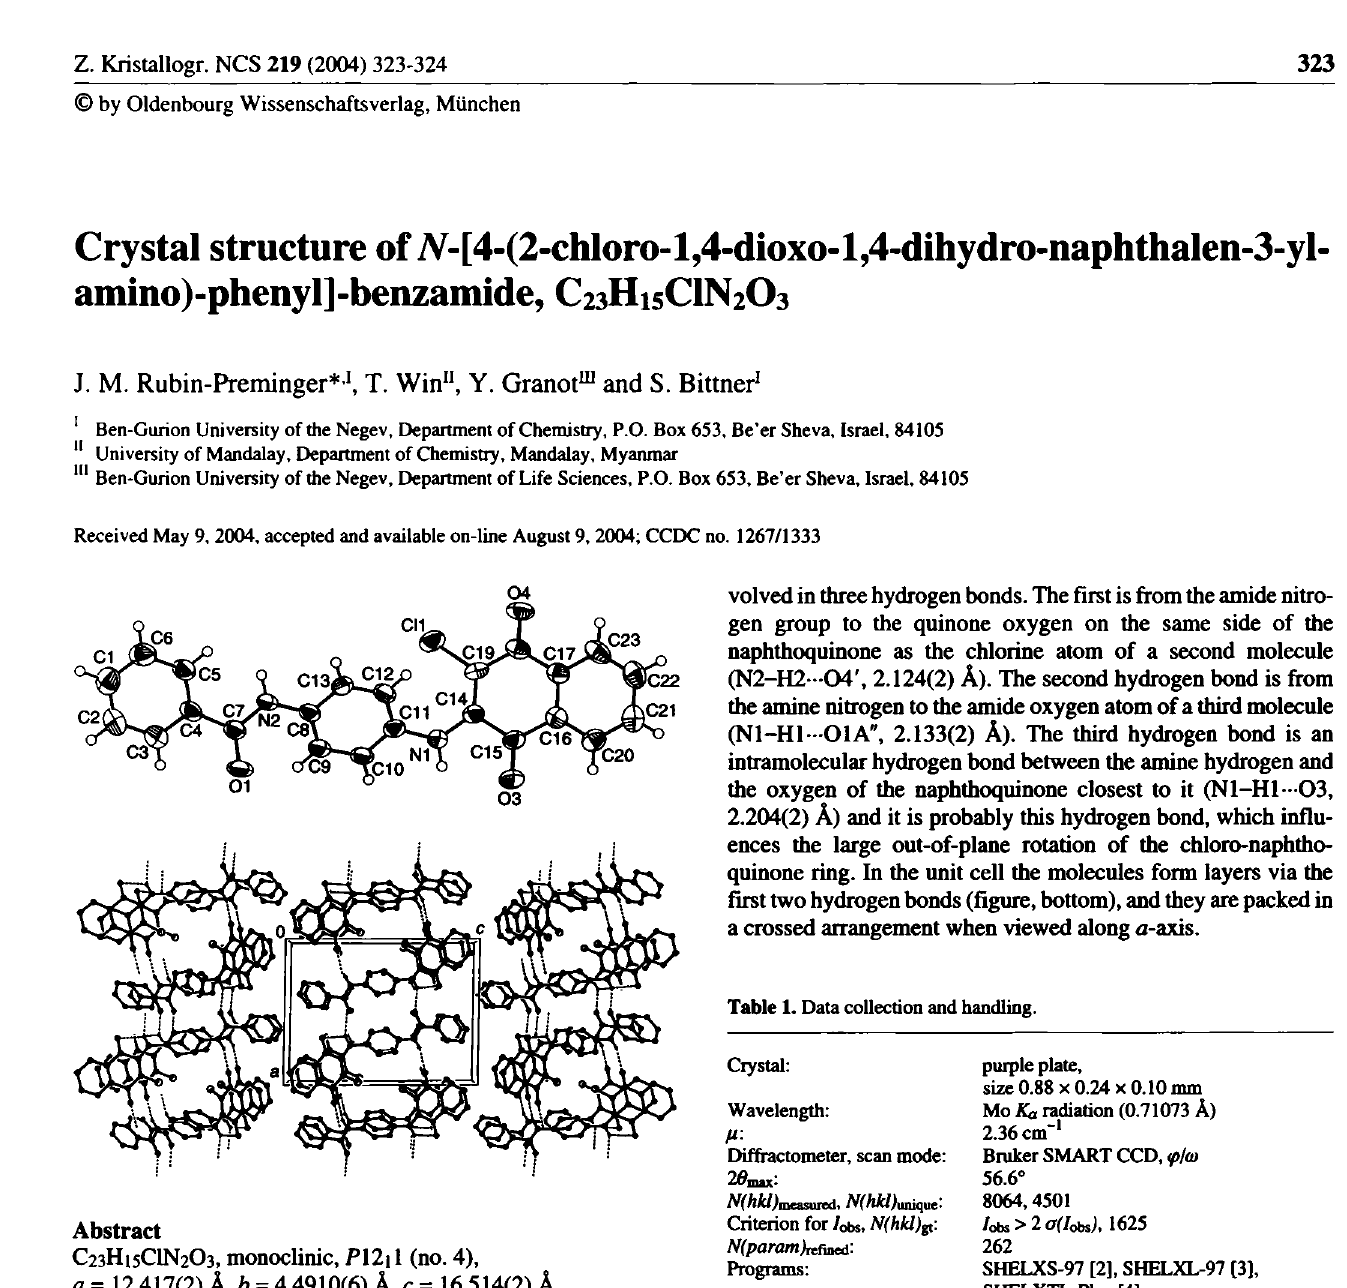
Table 2. Atomic coordinates and displacement parameters (in Ä 2